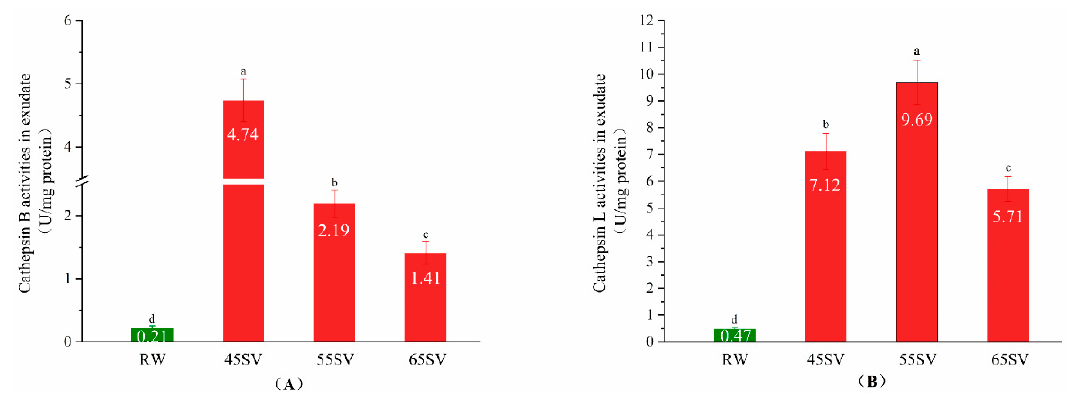
Figure 1. Cathepsin B ( A ), Cathepsin L ( B ) activity in exudate of RW and SV with di ff erent temperature. Di ff erent letter (a–d) statistically indicates the significant di ff erences on the activity of cathepsin B ( p < 0.05, n = 5).